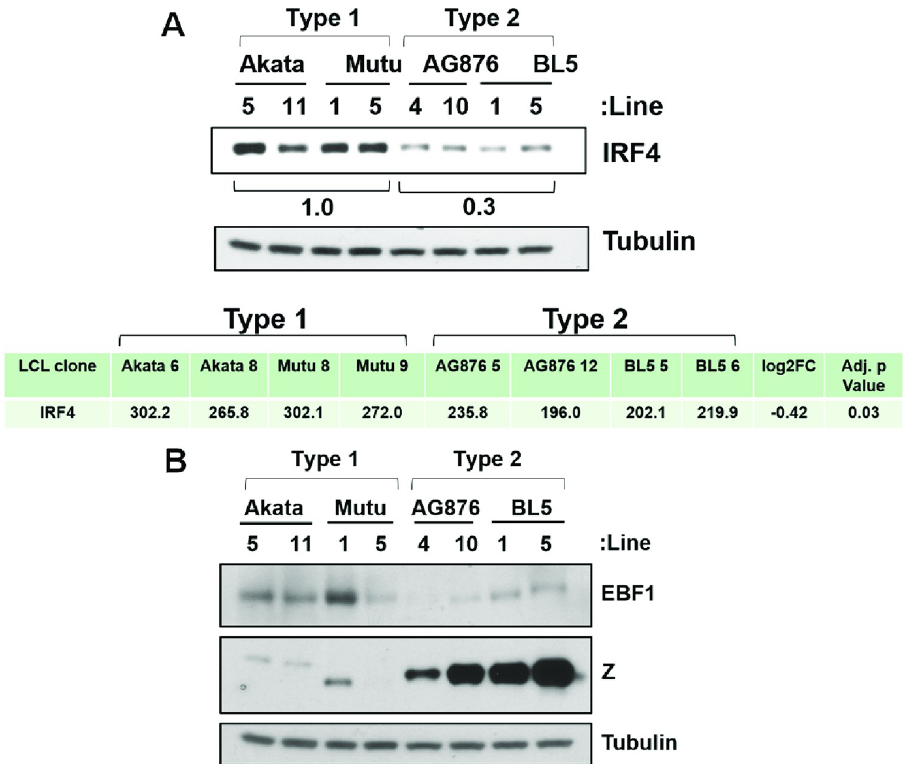
Fig 7. T2 LCLs express lower levels of IRF4 and EBF1 compared T1 LCLs. Immunoblot analyses were performed to compare the protein expression levels of IRF4 (A) or EBF1 and Z (B) in T1 versus T2 LCLs as indicated (using the same cell lysates). Tubulin was used as loading control. The numbers below the IRF4 immunoblot quantify the results using Image Studio Lite software to normalize the level of IRF4 expression to tubulin expression. Results are presented as the ratio of IRF4 expression relative to tubulin, in T2 cells (averaged) relative to T1 cells (averaged). The T1 IRF4 value is set as 1. The transcript expression of IRF4 (as determined by RNA-seq) is also shown for various different Type 1 and Type 2 LCL lines, along with the log2FC fold change in gene expression in T2 versus T1 cell lines, and the adjusted p